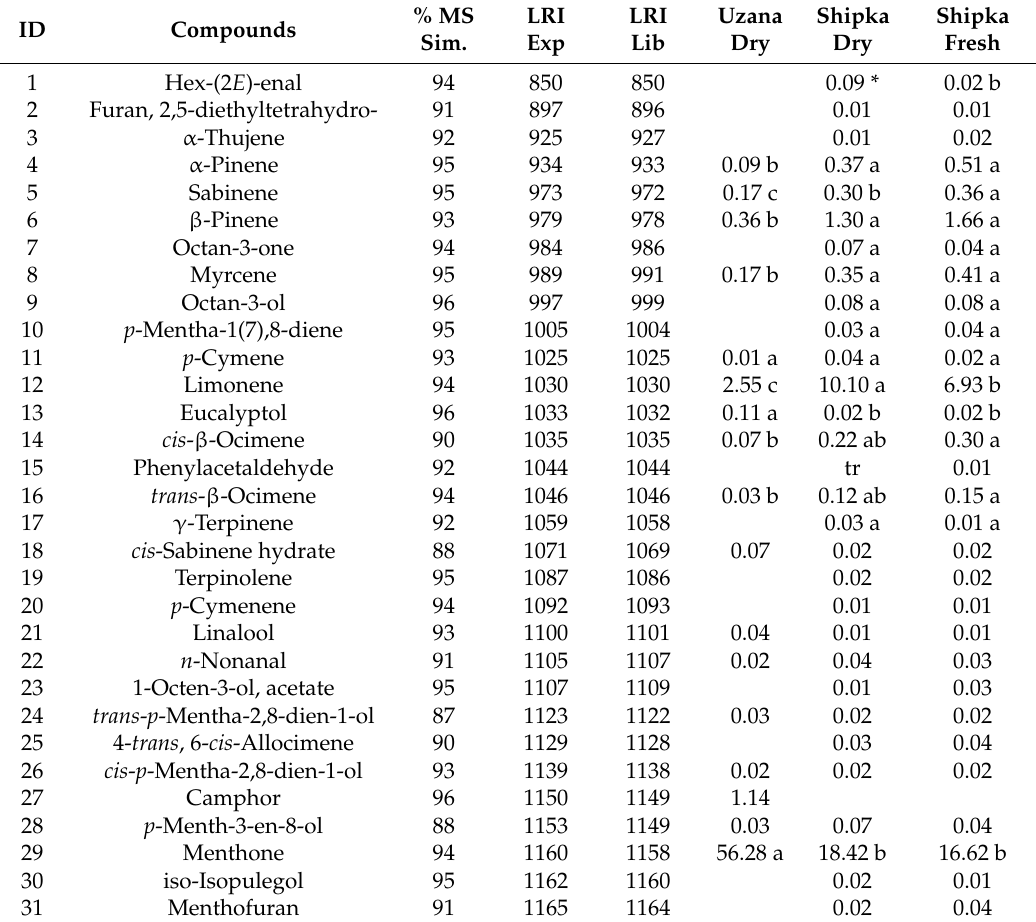
Table 1. The identification of the volatile fraction in Micromeria frivaldszkyana essential oils by using LRI (Linear Retention Index). LRI lib are values reported in FFNSC 3.01 library; LRI exp are obtained experimentally on SLB-5ms column. % MS Sim. represents the similarity between experimental and library spectra. The quantification of flavour and fragrance compounds in Micromeria frivaldszkyana essential oils by GC-FID % area values are the average of three